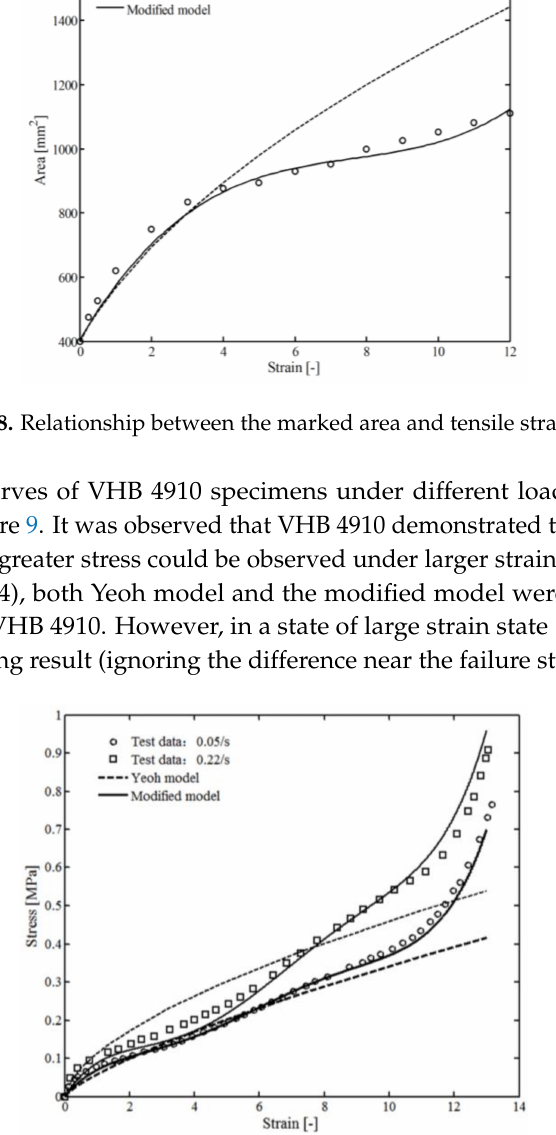
Figure 9. Relationship between stress and strain under different loading rates